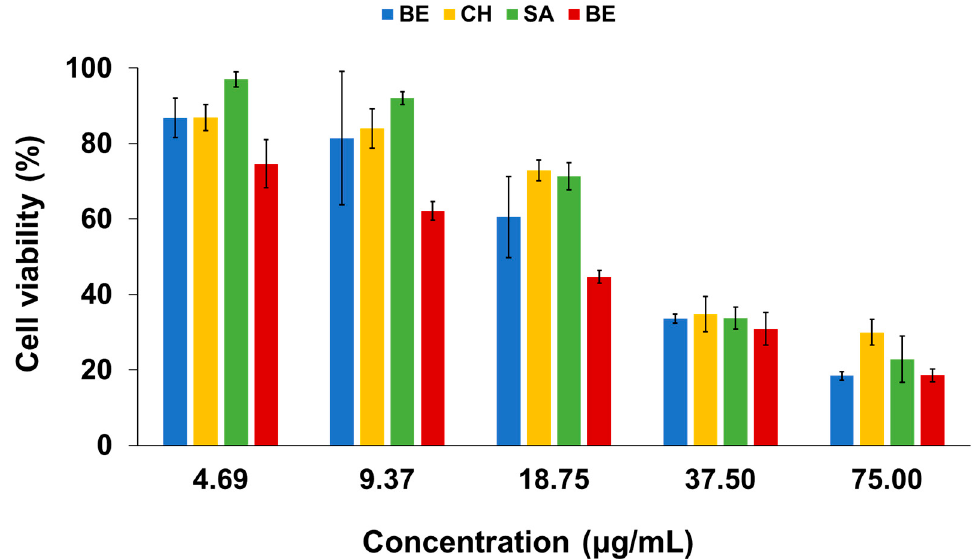
Figure 3. Antiproliferative activity of the four varieties of Z. officinale essential oils against the HeLa cervical cancer cell line. Z. officinale varieties: Bentong (BE), Cameron Highlands (CH), Sabah (SA), and Bara (BA). Values are means of three replicates ± standard deviation.